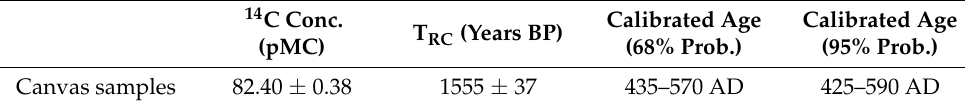
Table 1. Results of the radiocarbon measurements of the canvas fragment.